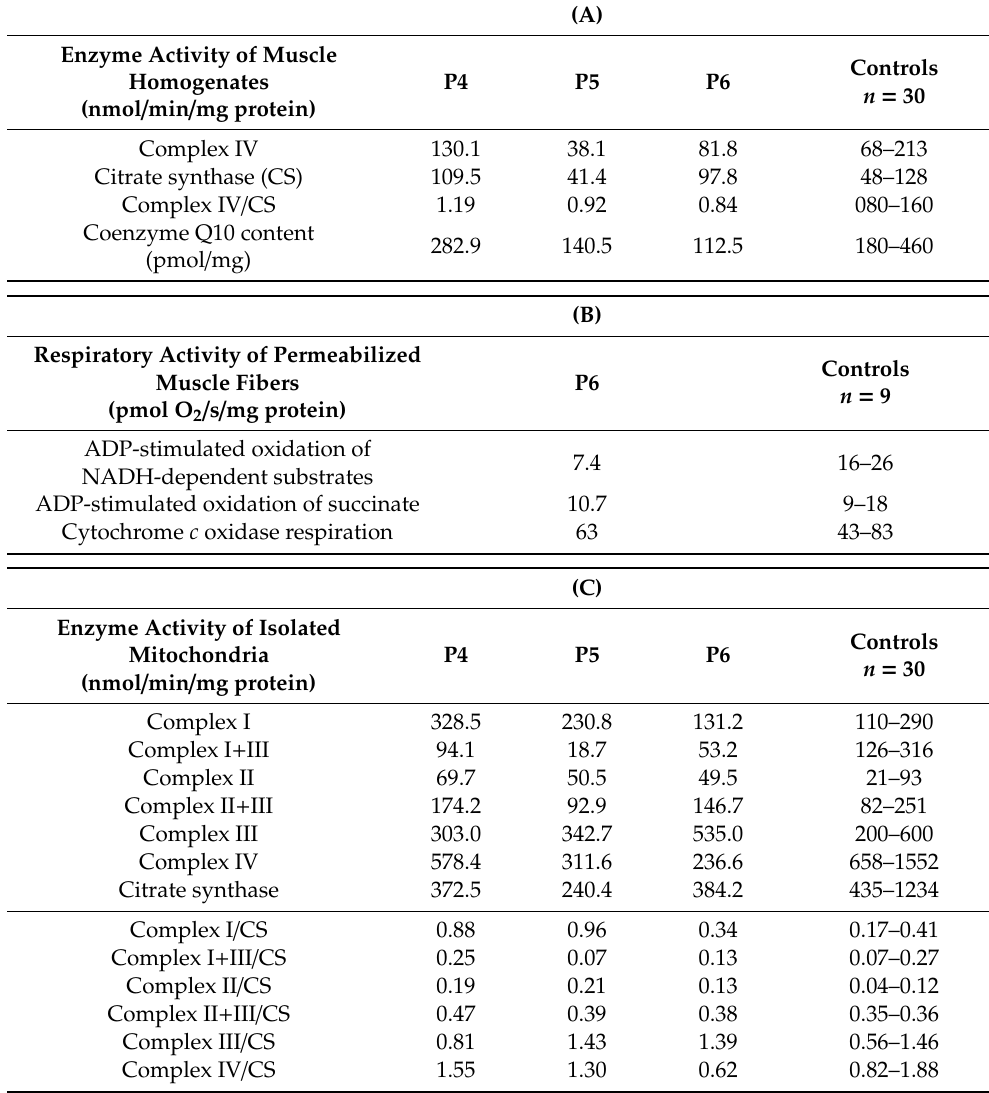
Table 1. Activities of respiratory chain enzymes in skeletal muscle homogenates ( A ), muscle fibers ( B ), and isolated mitochondria ( C ) of proband P4–P6. For analysis samples of m. tibialis (P4, P5) or m. deltoideus sin. (P6) were used. Enzyme activities and Coenzyme Q10 content are expressed per mg